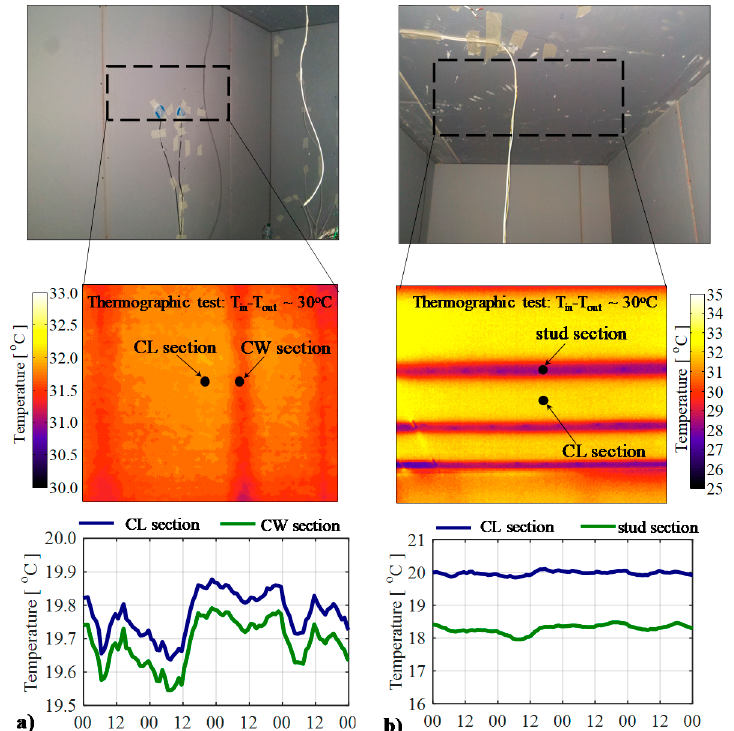
Figure 6. Infrared (IR) images and temperature measurements during the winter days (maximum temperature di ff erences between the “CW” and “CL” sections) at the internal surface of ( a ) wall and ( b ) roof.